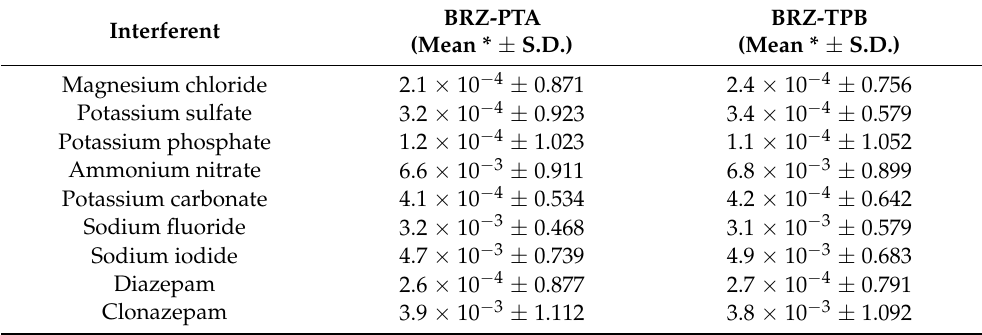
Table 2. Potentiometric selectivity coefficients of the proposed bromazepam-selective sensors by matched potential method.